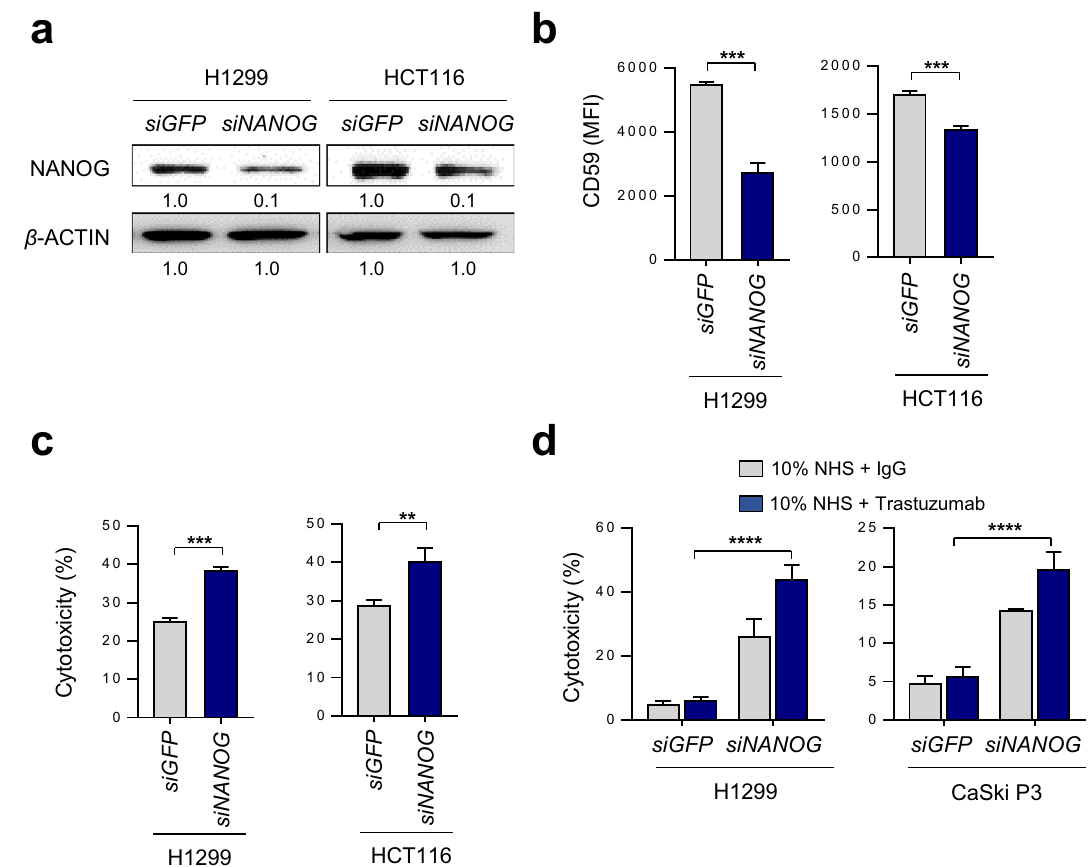
Figure 5. NANOG confers resistance to CDC in multiple types of human cancer cells via up-regulating CD59. ( a – c ) H1299 and HCT116 cells were transfected with siRNAs targeting GFP or NANOG. (a) The NANOG protein level was analyzed by Western blot. β -ACTIN was included as an internal loading control. Numbers below blot images indicate the quantitative value, as measured by fold change. Original blots were presented in Supplementary Fig. S9. (b) Protein levels of CD59 were determined by flow cytometry analysis. Data are presented as the mean fluorescence intensity (MFI). (c) CDC was measured by the LDH release assay after incubation with 20% NHS. (d) H1299 and CaSki P3 cells were transfected with siRNAs targeting GFP or NANOG. Trastuzumab-mediated CDC was measured by LDH assay, after incubation with 20% NHS in presence or absence of trastuzumab. All experiments were performed in triplicate, and error bars represent standard deviations from the mean. Differences in cytotoxicity or expression level were statistically tested using the Student’s t-test (b, c) or two-way ANOVA (d) : * p < 0.05; ** p < 0.01, *** p < 0.001, **** p <